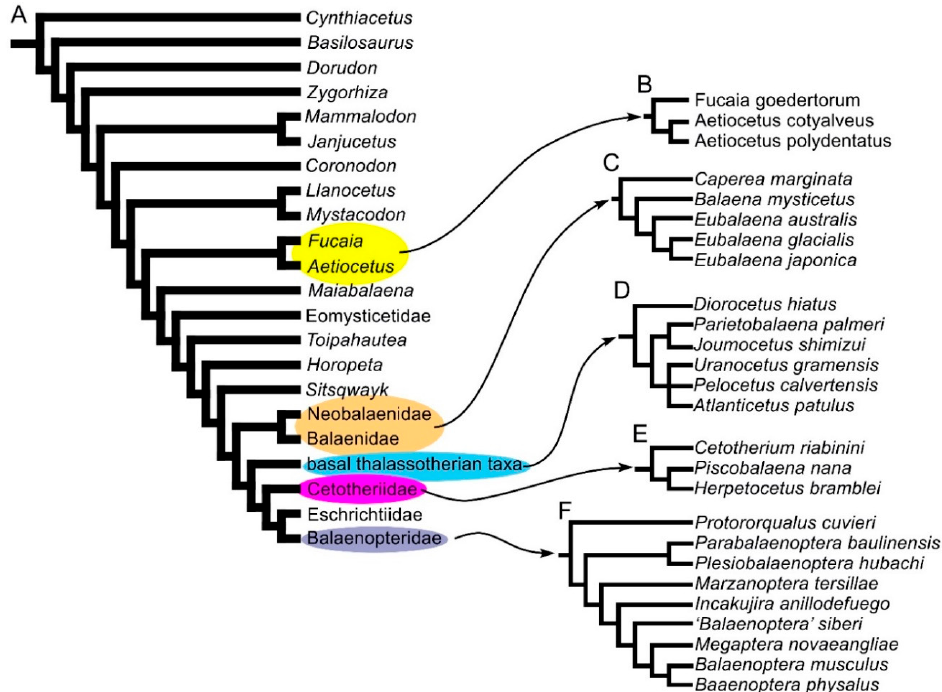
Figure 6. Intrafamily relationships among most of the mysticete species discussed in the text.The shown taxa are discussed in the present paper. ( A ) consensus phylogeny of Mysticeti adopted in the present paper. ( B ) relationships of aetiocetid taxa. ( C ) phylogenetic relationships of Balaenoidea. ( D ) relationships of basal thalassotherian taxa. ( E ) relationships of Cetotheriidae. ( F ) phylogenetic relationships of Balaenopteridae.